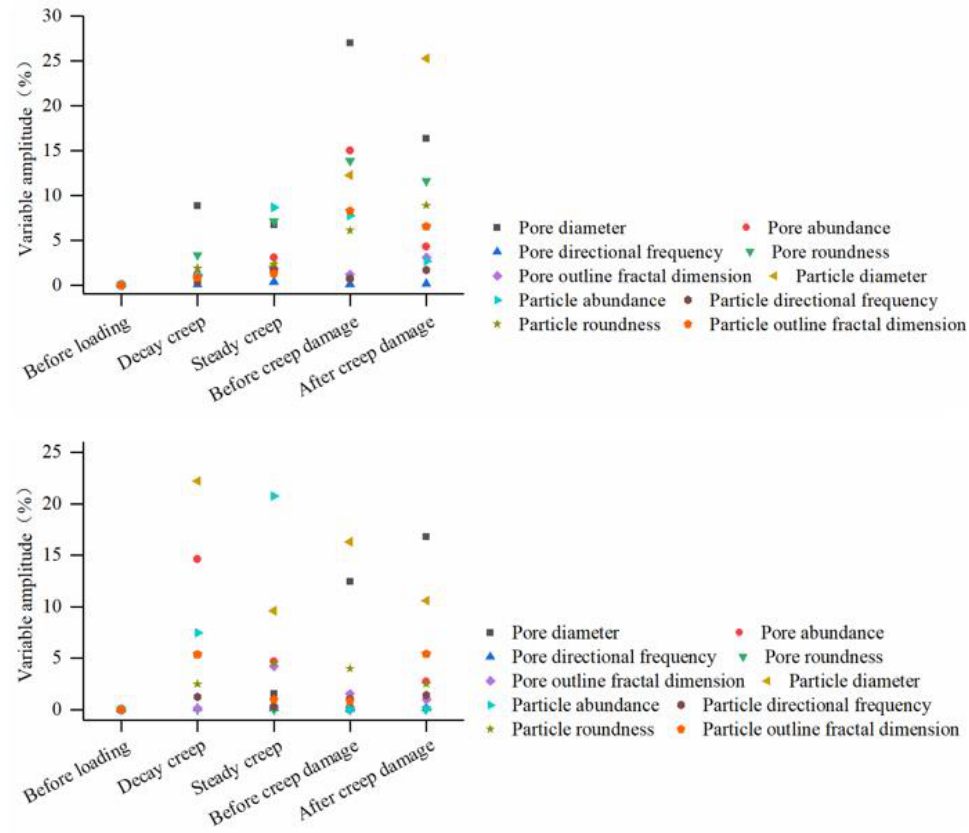
Figure 14. The magnitude of variation of microstructural parameters of intact loess and remolded loess.